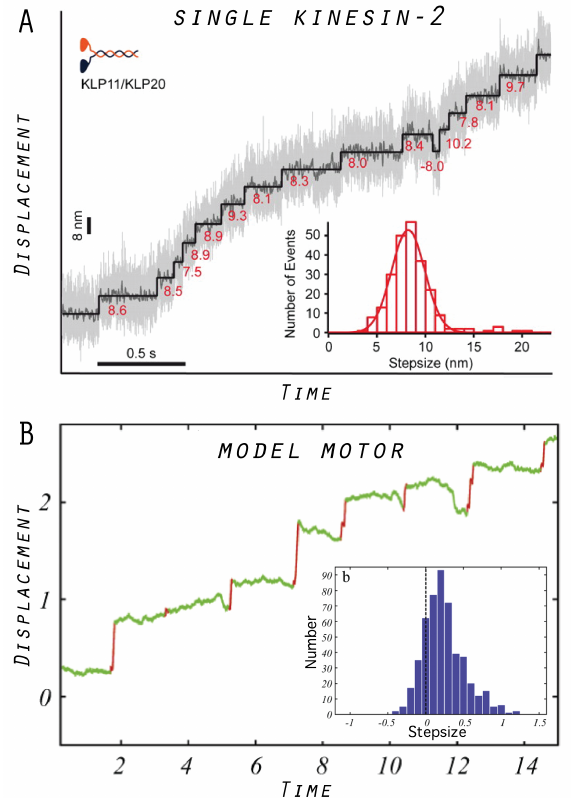
Figure 4. Examples of motor operation: ( A ) Stepwise processive transport by a kinesin-2 motor observed in single-molecule assays under saturating ATP concentrations. The stepsize distribution is also shown. The figure is taken from Reference [31]. ( B ) An example trace of filament transport by the designed in silico model motor, and the stepsize distribution obtained from the analysis of 1000 operation cycles (adapted from Reference [22] with